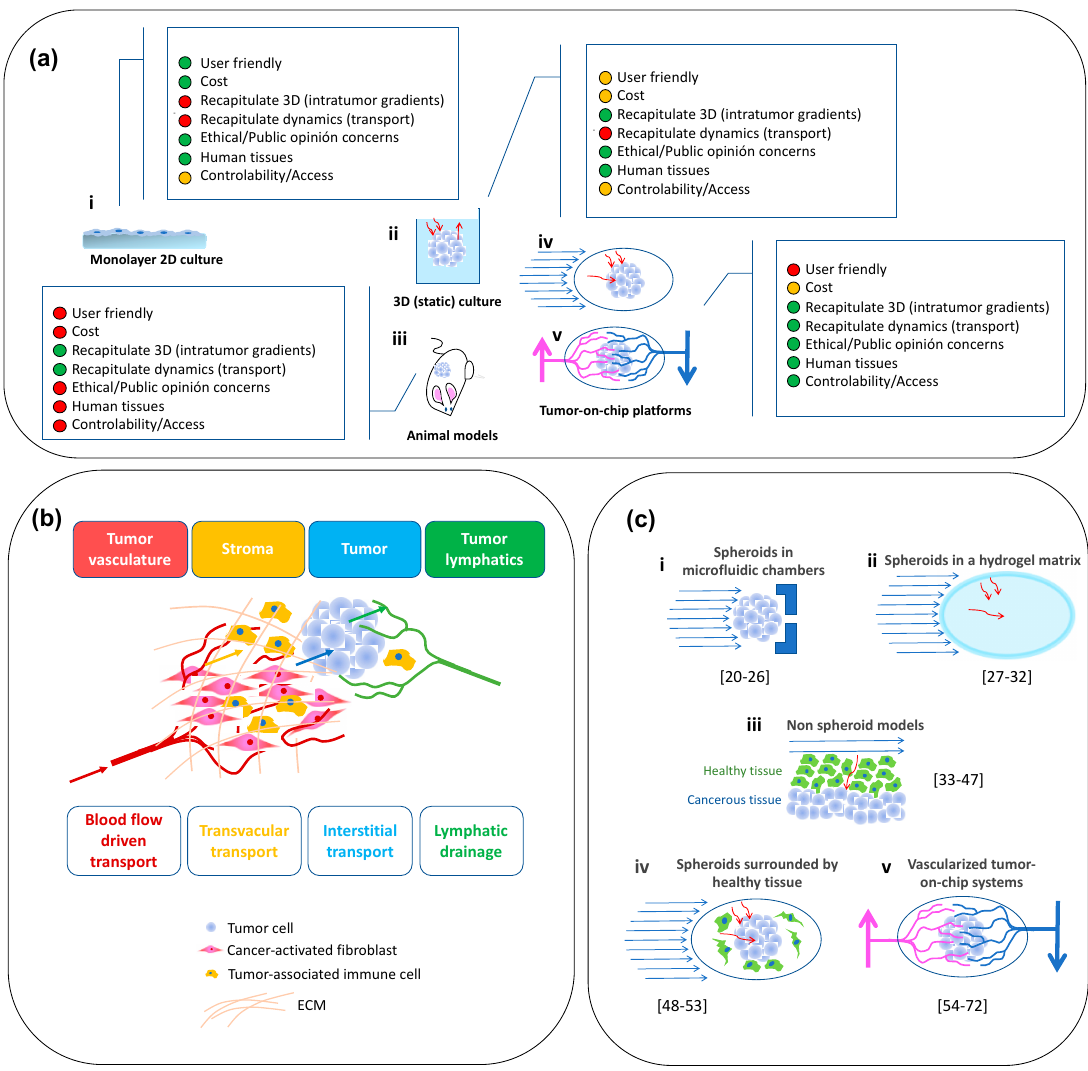
Figure 1. Recapitulation of the tumor niche using tumor-on-chip systems with various degrees of sophistication. ( a ) The evolution of our cancer research tools—from 2D to 3D, and beyond—tumor-on-chip systems. Colored circles show the degree of fulfillment of different features. Green: fully fulfilled; Yellow: partially fulfilled; Red: poorly fulfilled; ( b ) Scheme of the tumor niche. Modified from Han et al., 2016 [19]. ( c ) Different types of tumor-on-chip systems: from simple spheroids in a microflow to vascularized and perfusable tumor microtissues [20–72].